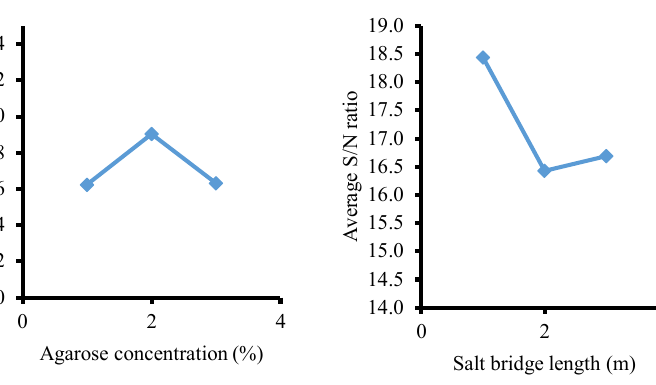
Fig. 10: Average S/N ratio for maximum power